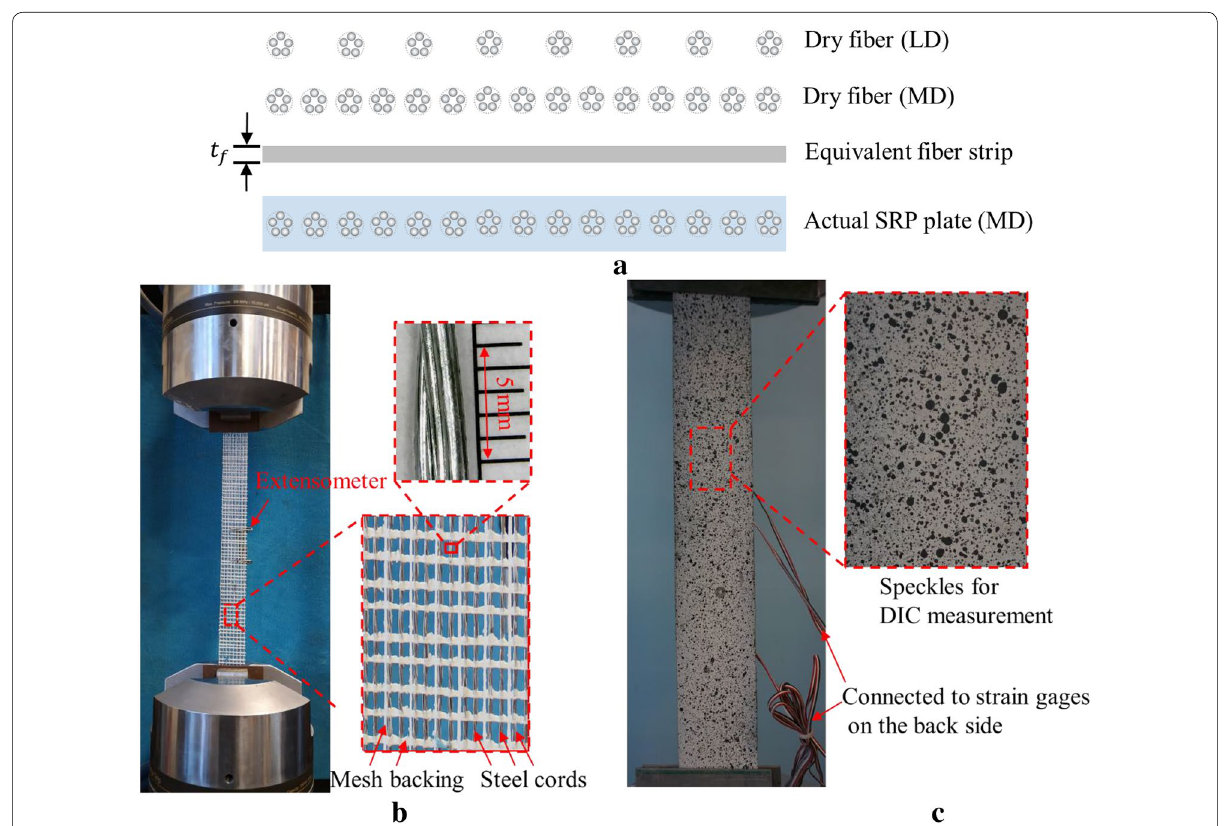
Fig. 1 a Details of fibers and SRP plates, b tensile test of MD bare fiber sheet, and c tensile test of SRP plate with MD